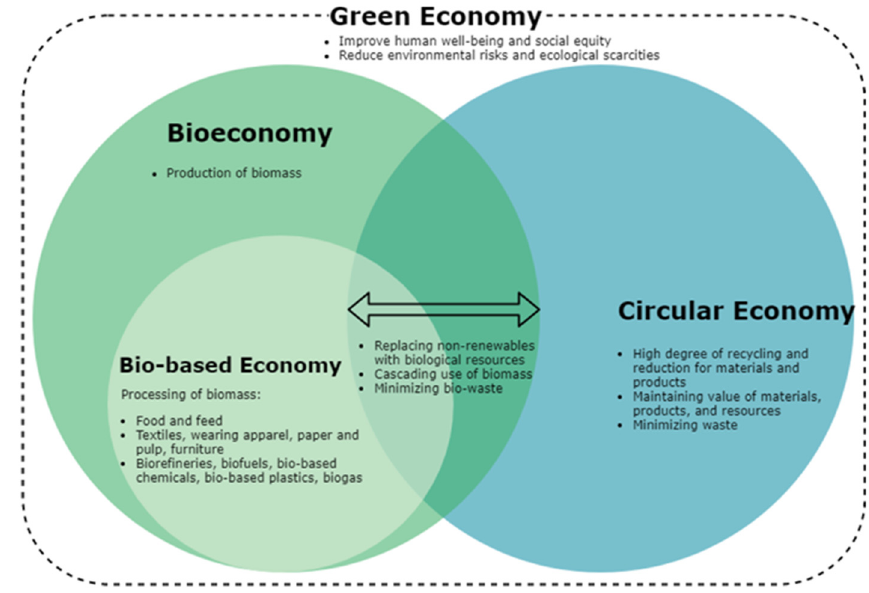
Figure 2. Relations between bio-, bio-based, green and circular economies.[68]